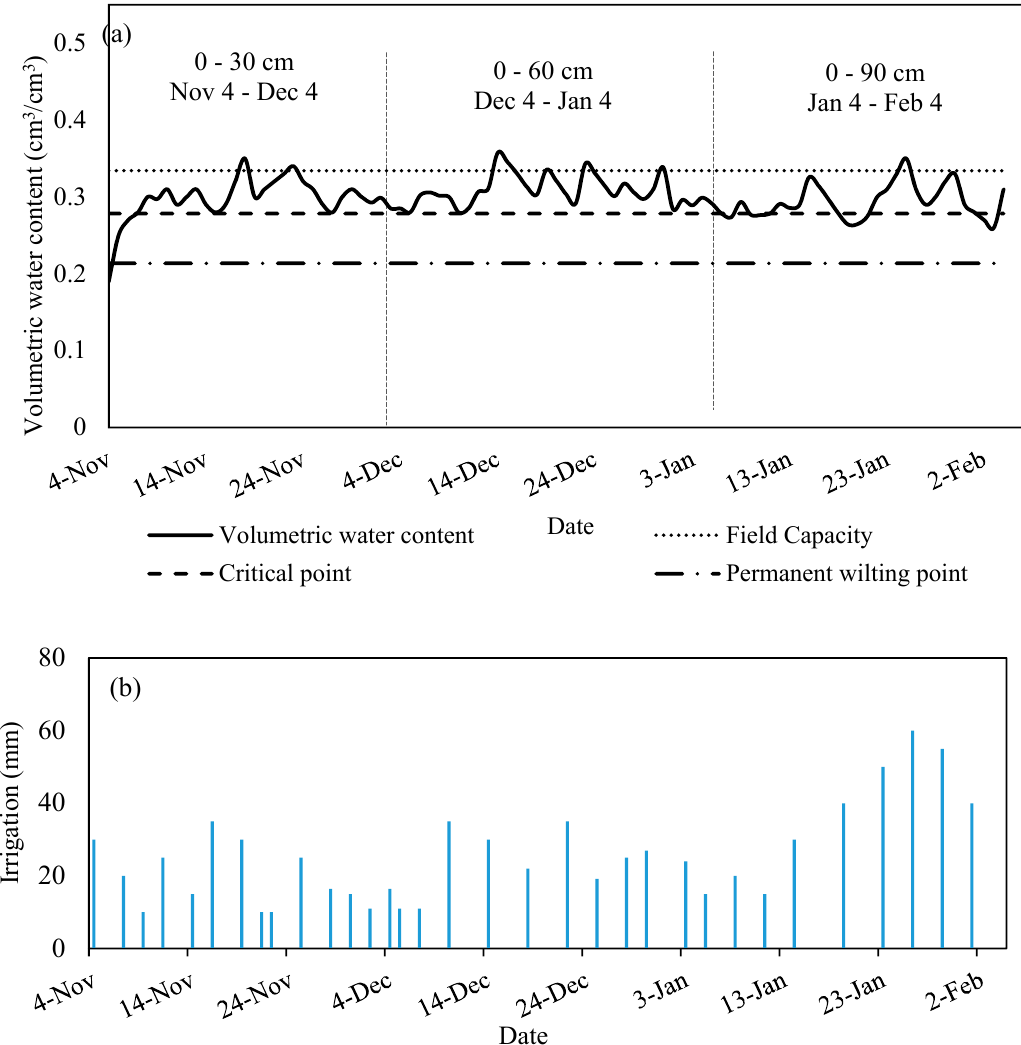
Figure 3. ( a ) Soil moisture content measurements for the control treatment at the desired depth of soil profile and ( b ) irrigation water applied to the lysimeters.